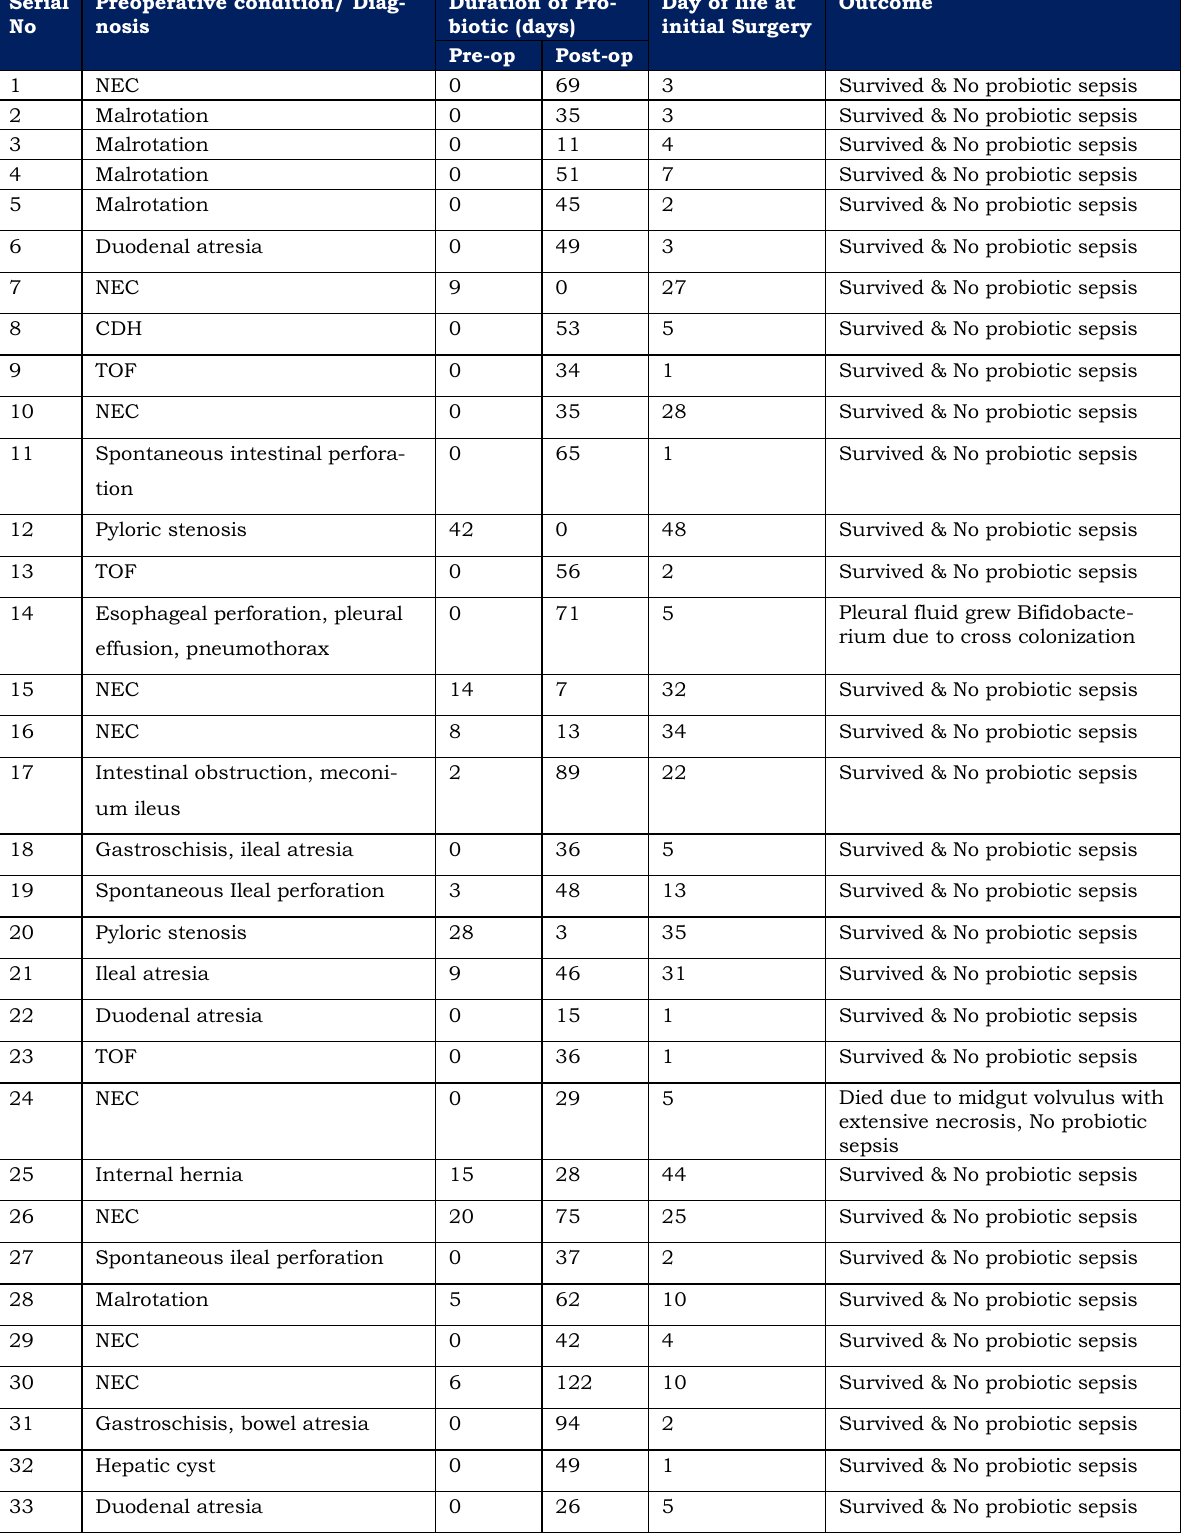
Table 3.Description of Individual